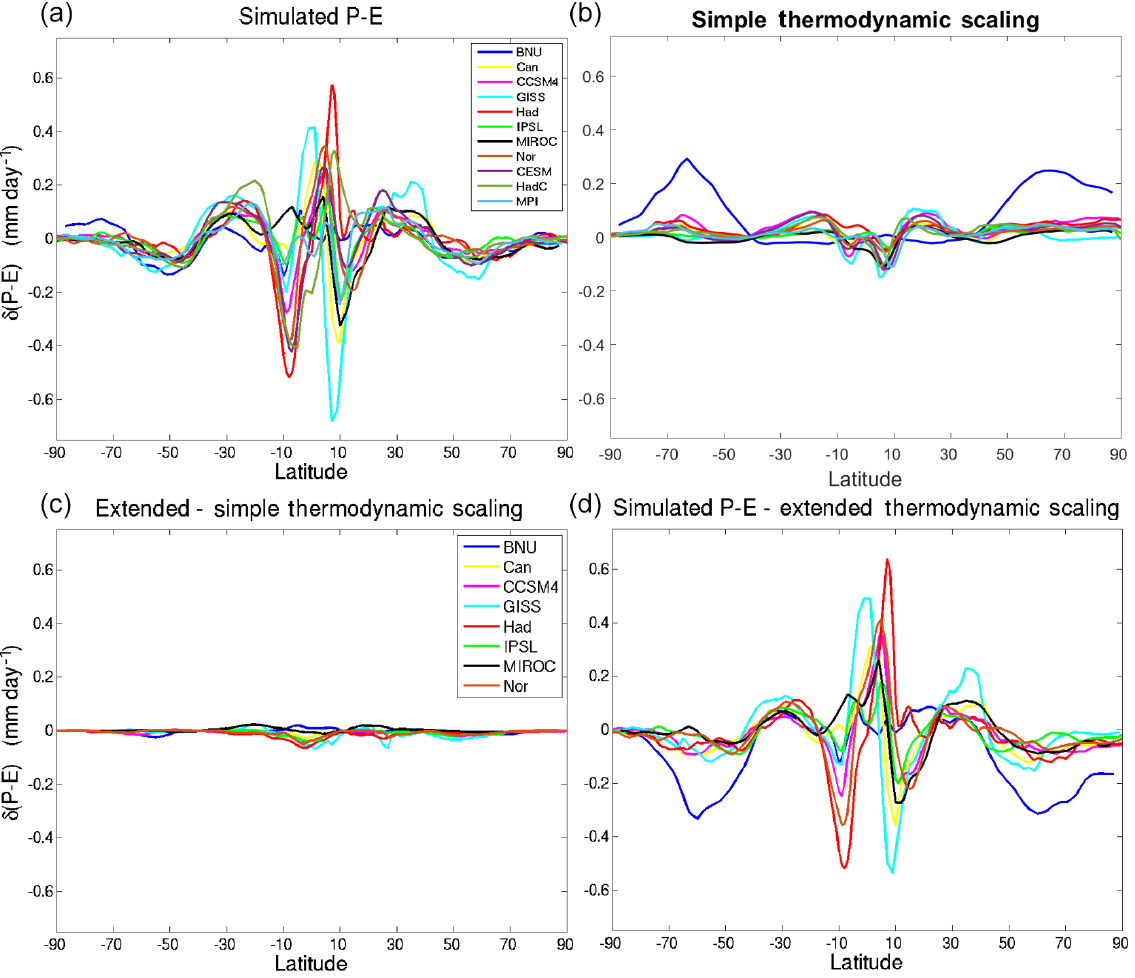
Figure 4. (a) The zonal mean δ(P − E) for G1-piControl simulated in 11 climate models and (b) the P − E anomaly predicted by the simple thermodynamic scaling in Eq. (2). (c) The difference in the G1-piControl δ(P − E) predicted by the extended (Eq. 3) and simple (Eq. 2) scalings. This isolates the contribution of local relative humidity changes to the P − E anomalies. (d) The difference between the simulated G1-piControl δ(P − E) and the P − E anomaly predicted by the extended scaling and the changes in dynamically driven rainfall (EC-Earth excluded due to unphysical